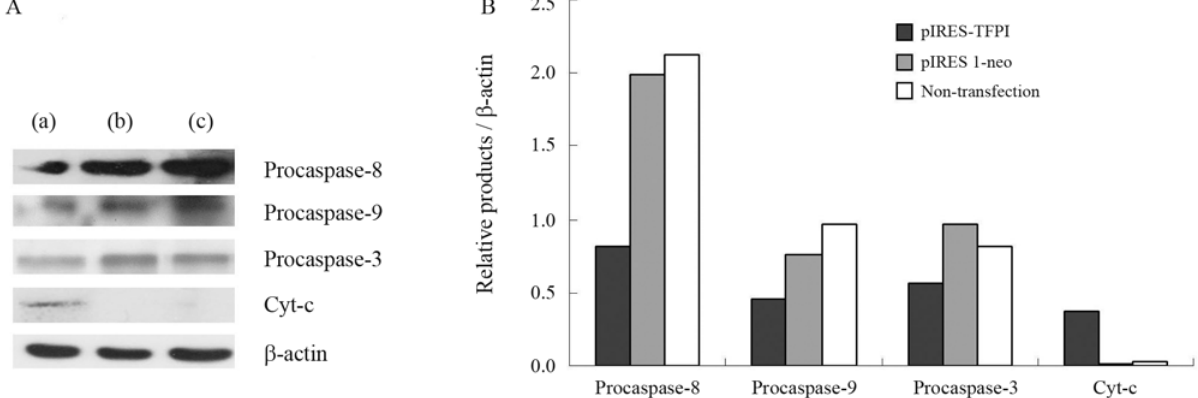
Figure 4 - Western blot analysis for procaspase-8, procaspase-9, procaspase-3, and cyt-c. (A) Representative data of Western blotting for pIRES-TFPI treatedgroup(a),pIRES1-neotreatedgroup(b)andnon-transfectiongroup(c);(B)proteinlevelsstandardizedby (cid:4) -actin. * p<0.05ascomparedwiththe pIRES 1-neo group (n =